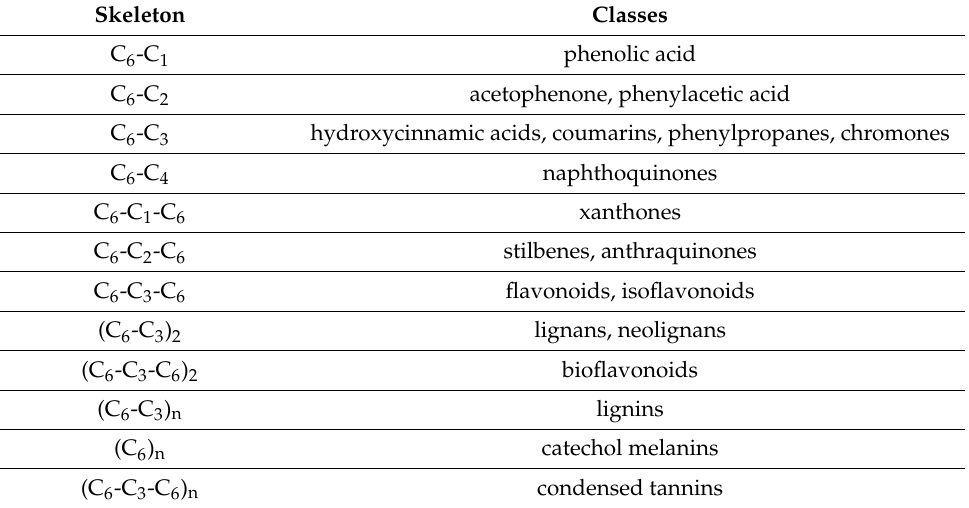
Table 1. Classes of phenolic compounds categorized on the basis of their skeleton of C [235–237].